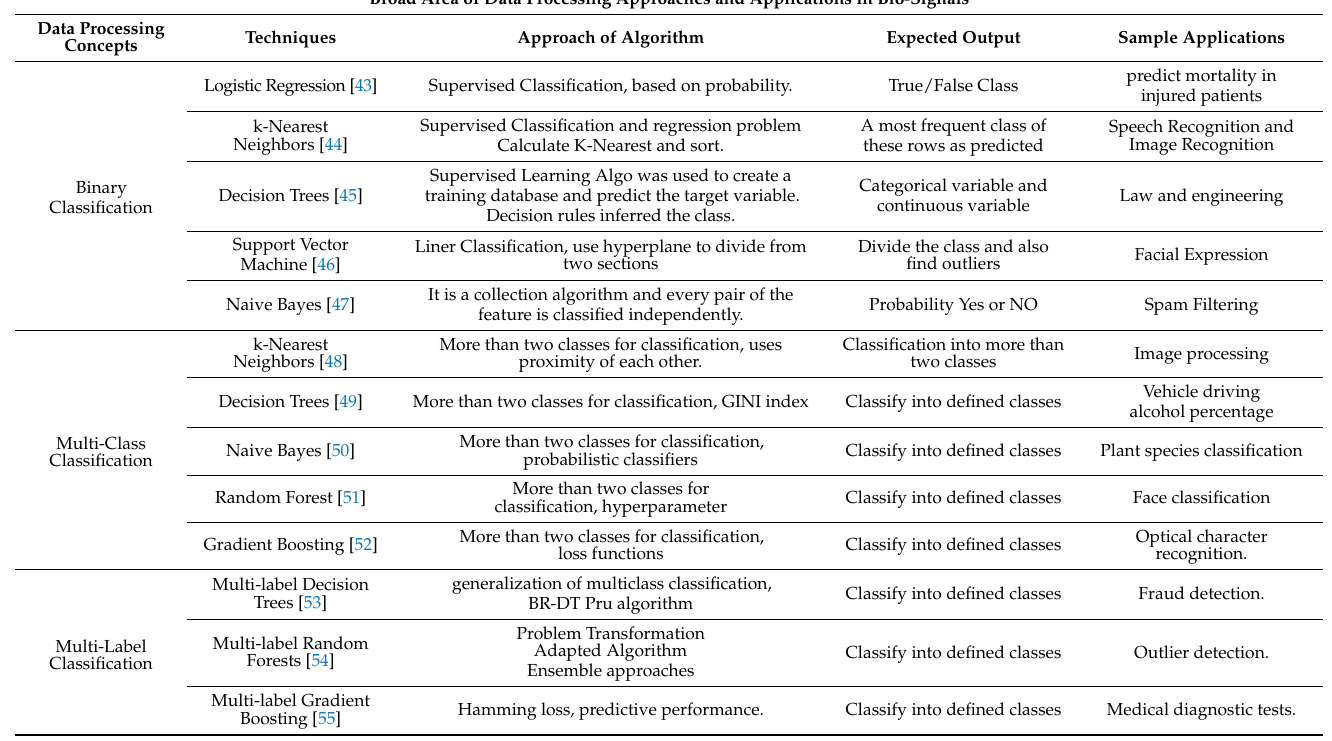
Table 2. Applications of